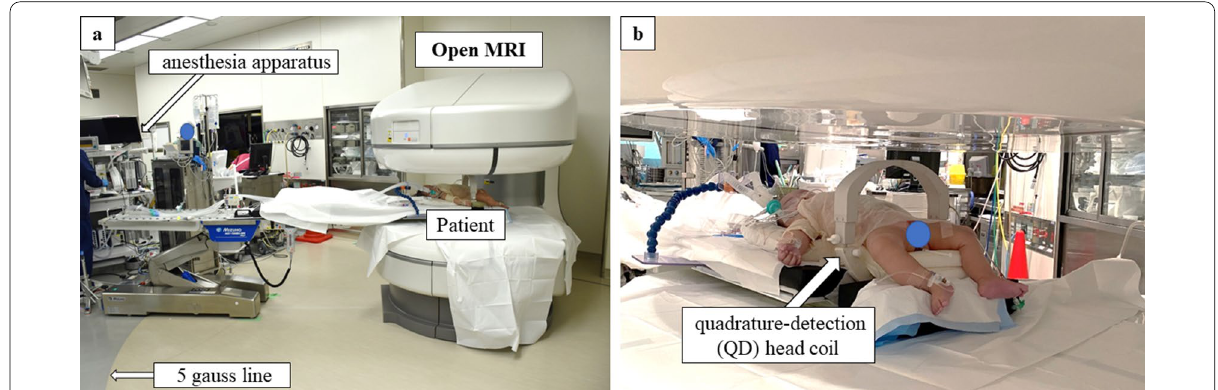
Fig. 4 a Long respiratory tube between the anesthetic instrument and the gantry was needed for general anesthesia. b Patient was inserted into the gantry for open MRI scanning. The quadrature-detection (QD) head coil was attached around the patient’s pelvis